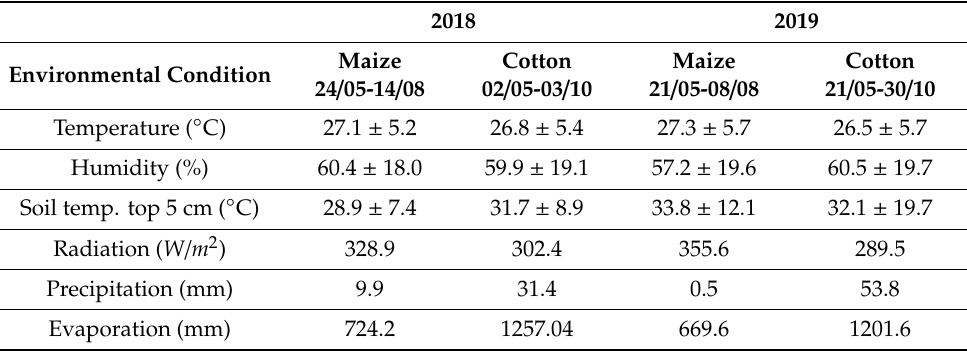
Table 2. Meteorological data for the 2018 and 2019 experiments.